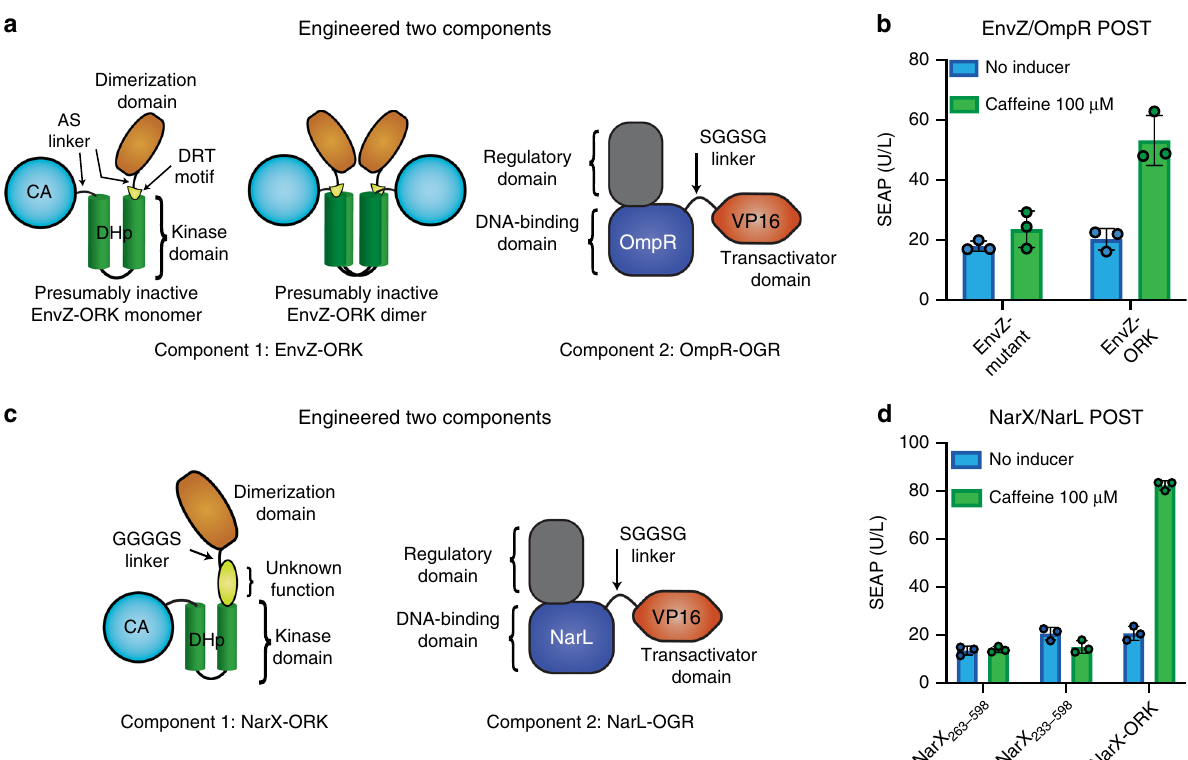
Fig. 7 EnvZ/OmpR and NarX/NarL POST. a Schematic of the engineered ORK/OGR proteins based on EnvZ/OmpR. In the ORK, short linkers consisting only of the two amino acids AS were used to reduce interdomain fl exibility between the acV H H and the kinase domain and between the CA and DHp domains by replacing the native GQEMP linker. We hypothesize that this change results in inactive dimers. b Induction of EnvZ/OmpR POST with caffeine. The EnvZ mutant without acV H H (EnvZ 232 – 450;GQEMP:AS ) was included as a negative control. c Schematic of the engineered ORK/OGR proteins based on NarX/NarL. d Induction of NarX/NarL POST with caffeine. The NarX truncations without acV H H were included as negative controls. The bar charts show the mean ± s.d. of n = 3 biologically independent samples overlaid with a scatter dot plot of the original data points, measured at 24 h after induction, and the results are representative of three independent experiments. Source data are provided as a Source Data fi